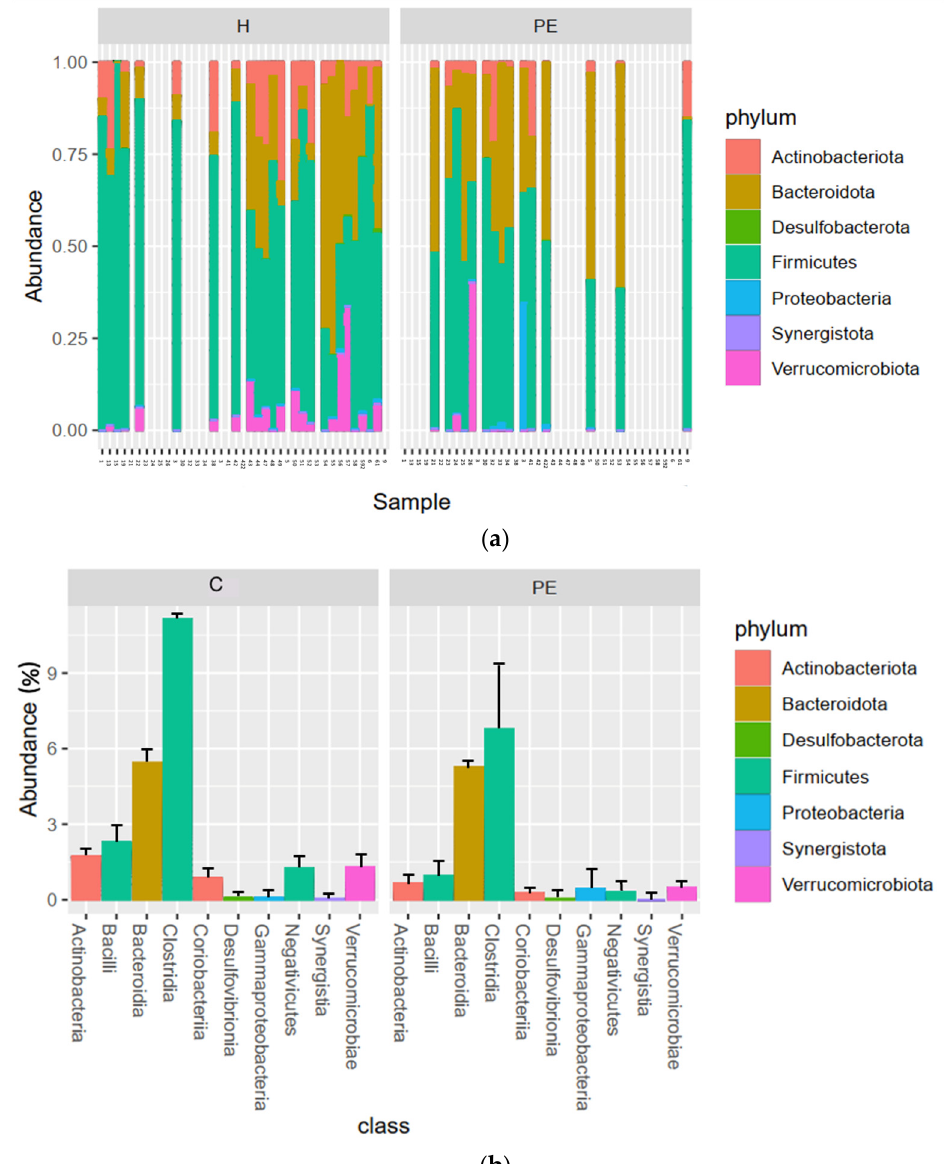
Figure 3. Stacked bar plots of the relative abundance with the standard deviation of bacterial taxa in the gut microbiota in 24 control and 15 PE pregnancies, based on successfully sequenced sam- ples of the 16S rRNA gene. Abundances at the phylum level in individual samples ( a ). Mean abun- dances according to group at the class level, with colors indicating phyla ( b ). Cutoff for taxon in- clusion = 0.005%.